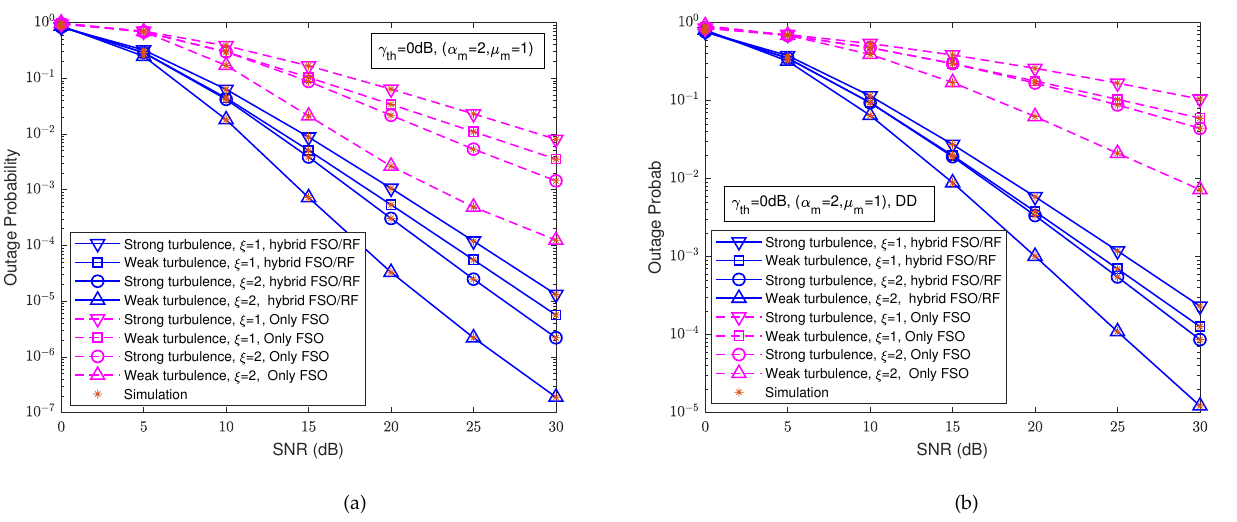
Figure 4. Relationship between OP and SNR of the hybrid system and only FSO system under different turbulence intensity, different pointing errors, and different detection techniques. ( a ) HD. ( b )